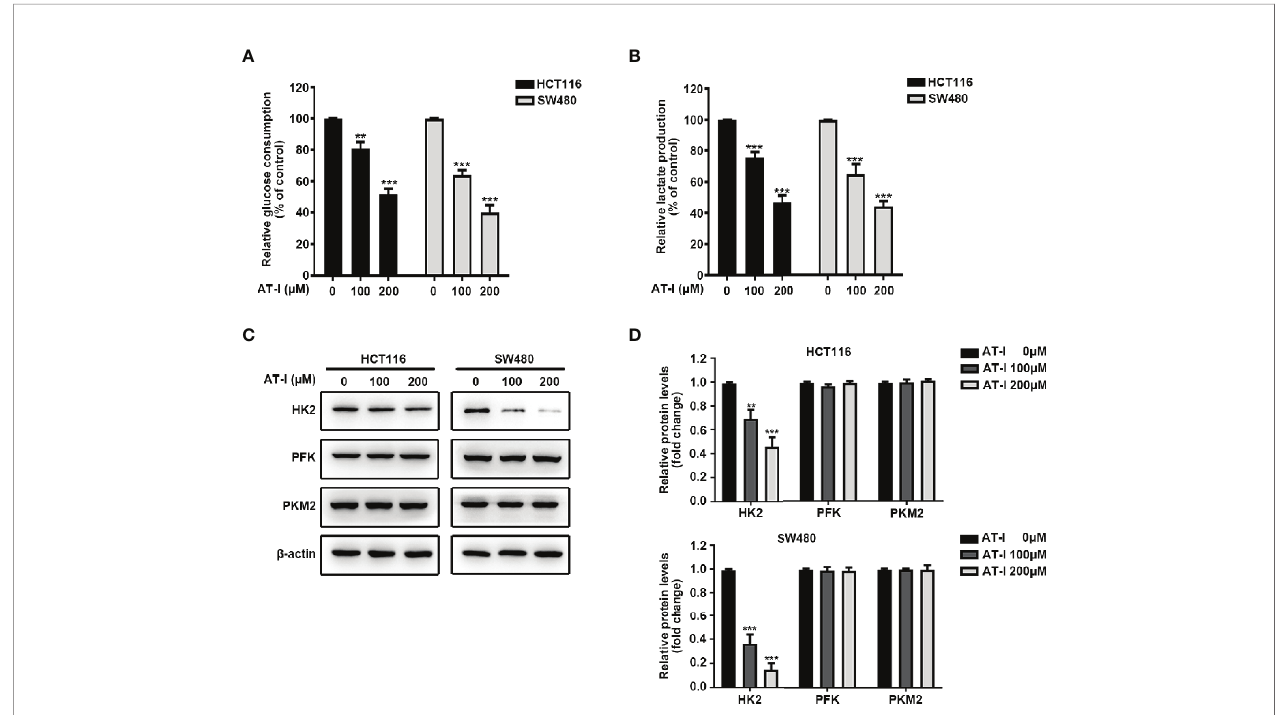
FIGURE 3 | AT-I suppression of glycolysis in CRC cells via a reduction in HK2 expression. (A) Glucose consumption and (B) lactate production were measured in the CRC cells treated with the indicated concentrations of AT-I for 24 h. (C) Western blot analysis of key glycolytic enzymes [hexokinase 2 (HK2), phosphofructokinase (PFK), and pyruvate kinase M2 (PKM2)] and quanti fi cation of the results. (D) Protein levels were normalized to those of b -actin, and these are shown as fold changes relative to the control group levels. ** p < 0.01 and *** p < 0.001 compared with the control group without any